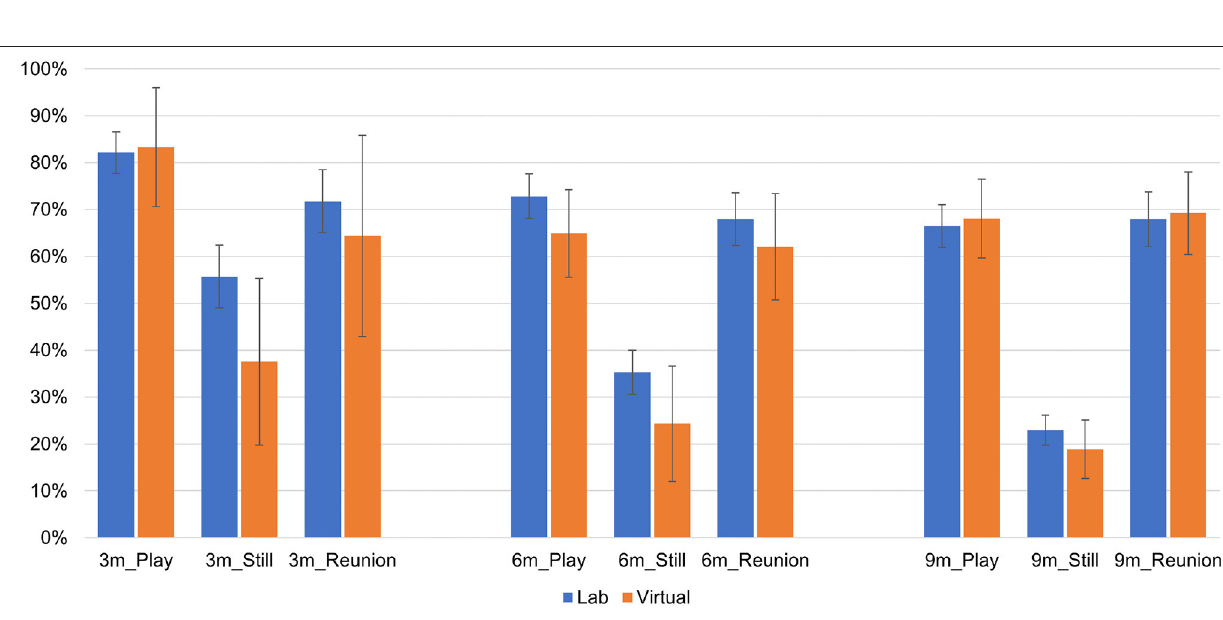
Receptive and Expressive Communication Scores Mean and standard deviations for infant receptive and expressive communication scores are shown by time point and visit type in Table 6 . Across all time points and for each subtest, t -tests for independent samples revealed no significant differences at p < 0.0125 (Bonferroni correction) in infant language scores as a function of virtual vs. lab visits (see Table 6